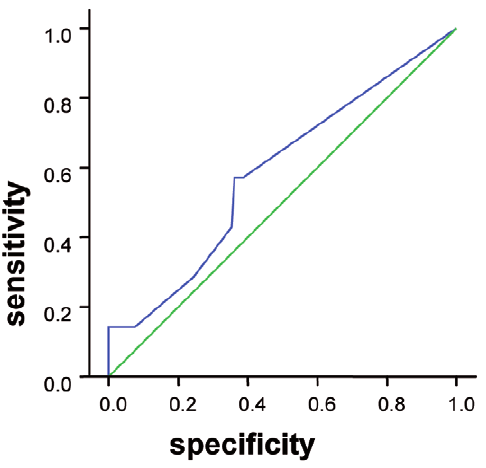
Figure 5. ROC curve demonstrating sensitivity and specificity.